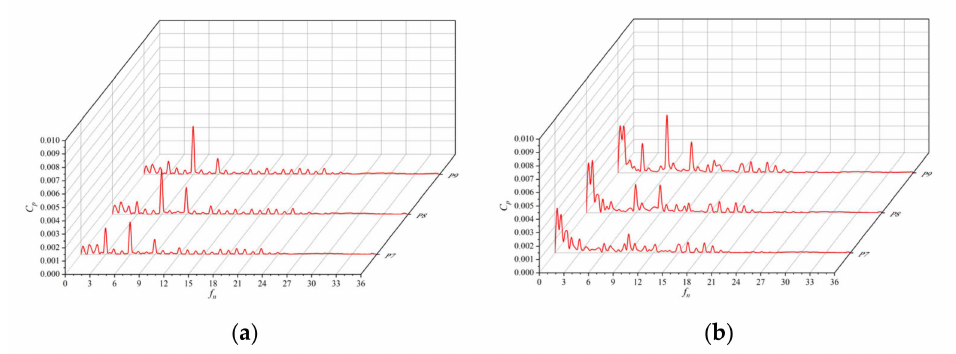
Figure 18. Frequency domain of pressure pulsation at guide vane outlet ( Q = Q d ): ( a ) shaft front positioned tubular pump device; ( b ) shaft rear positioned tubular pump